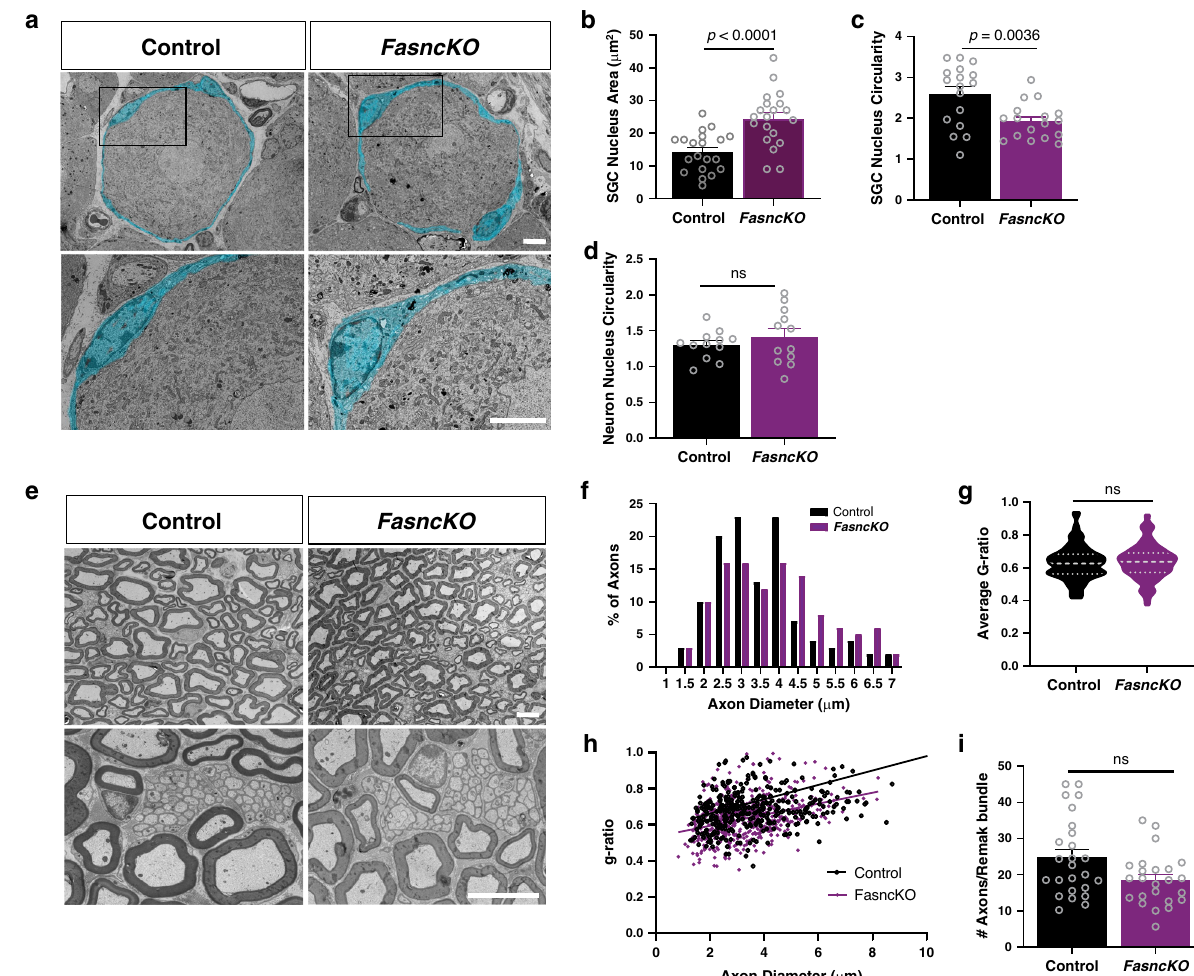
Fig. 4 Fasn deletion in SGC does not alter neuronal morphology. a Representative TEM images of a DRG cell body and its enveloping SGC sheath, pseudo-colored in turquoise, from control and FasncKO mice. High magni fi cation of boxed area from top panels are showed in bottom panels. Scale bar: 5 µ m. b Average SGC nuclear area. n = 20 cells examined over 3 independent experiments. c SGC nuclear circularity (ratio between major axis(X)